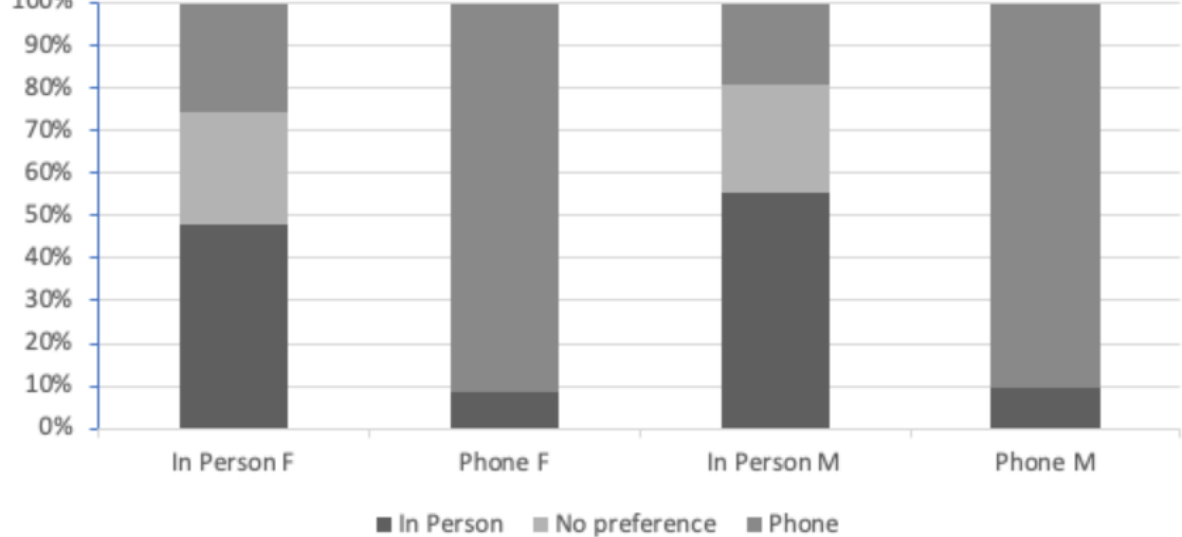
When analyzed by location, teleconsultation was preferred over in-person office visits by both city and rural community dwellers (Figure 3). Out of all the patients evaluated, 58.9% (234/397) of patients living in the city preferred teleconsultation compared to 47.6% (180/378) of patients living in a rural community